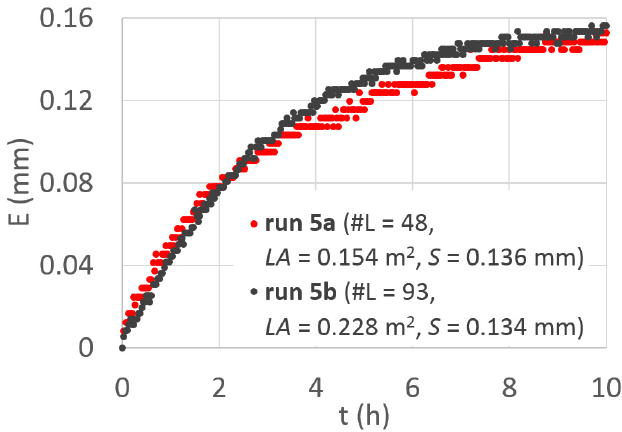
Figure 3. For runs #5a and #5b, temporal variation of the evaporation depth by the wet branches.